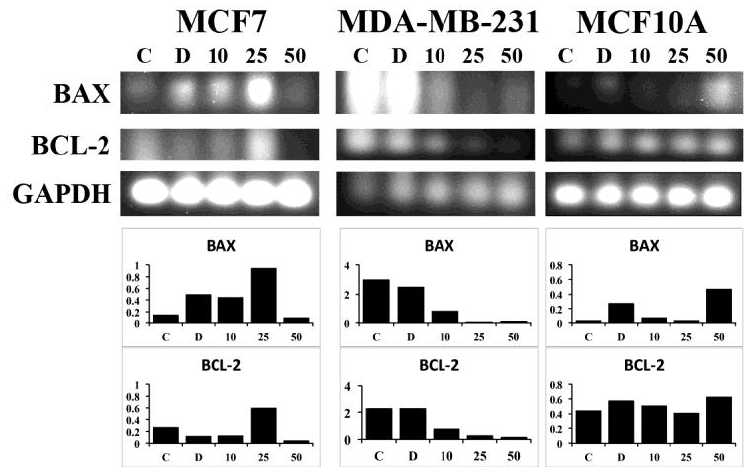
Figure 4. Gene expression of apoptotic mediators following ASX treatment. MCF7, MDA-MB-231, and MCF10A cells were treated with ASX for 24 h at the concentrations indicated. RT-PCR results are presented and the corresponding expression levels of the indicated gene normalized to GAPDH in arbitrary units. C-untreated, D-DMSO, 10 µ M, 25 µ M, and 50 µ M.